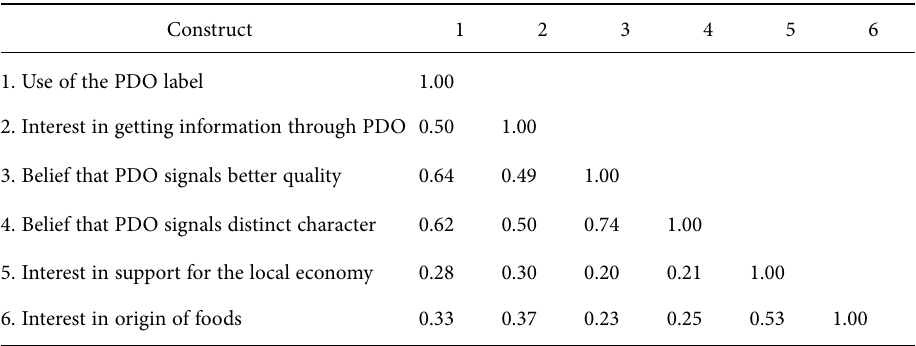
Table 3. Construct correlation matrix for PDO (n =